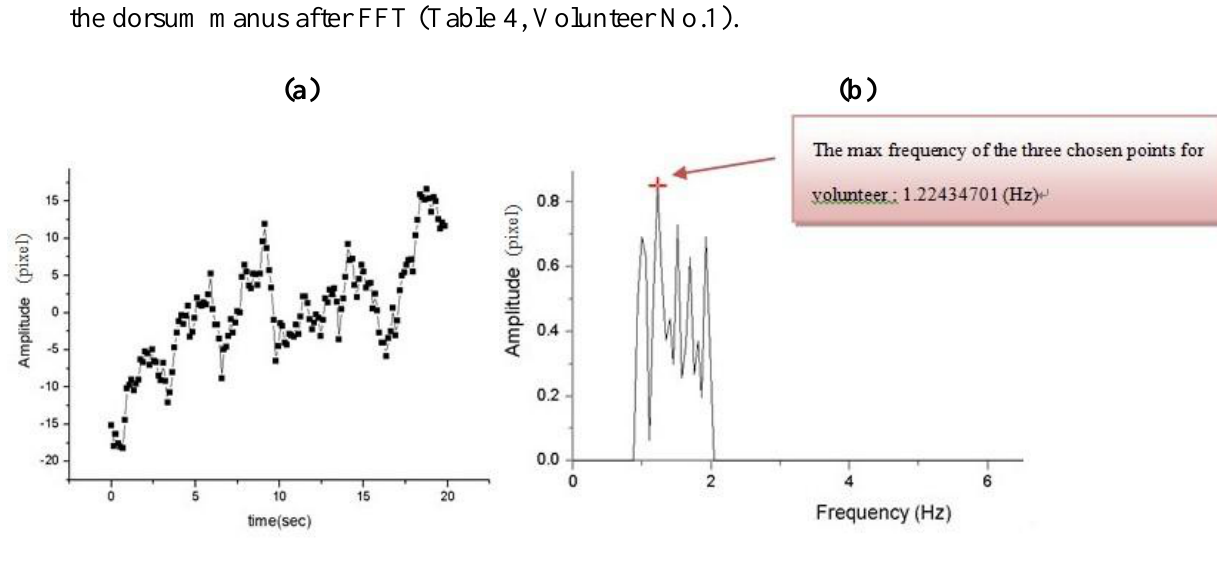
Table 3. Dorsum manus vibration frequency of control group (normal